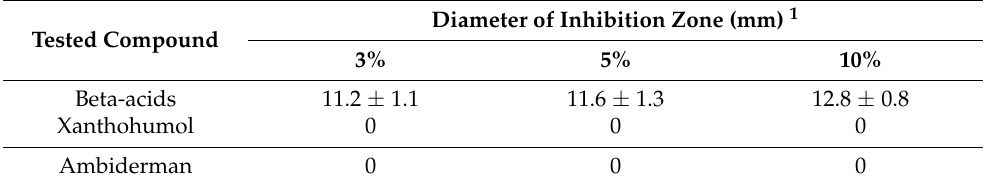
Table 1. The antimicrobial activity of hops compounds against the MRSA strain obtained by the agar diffusion method.